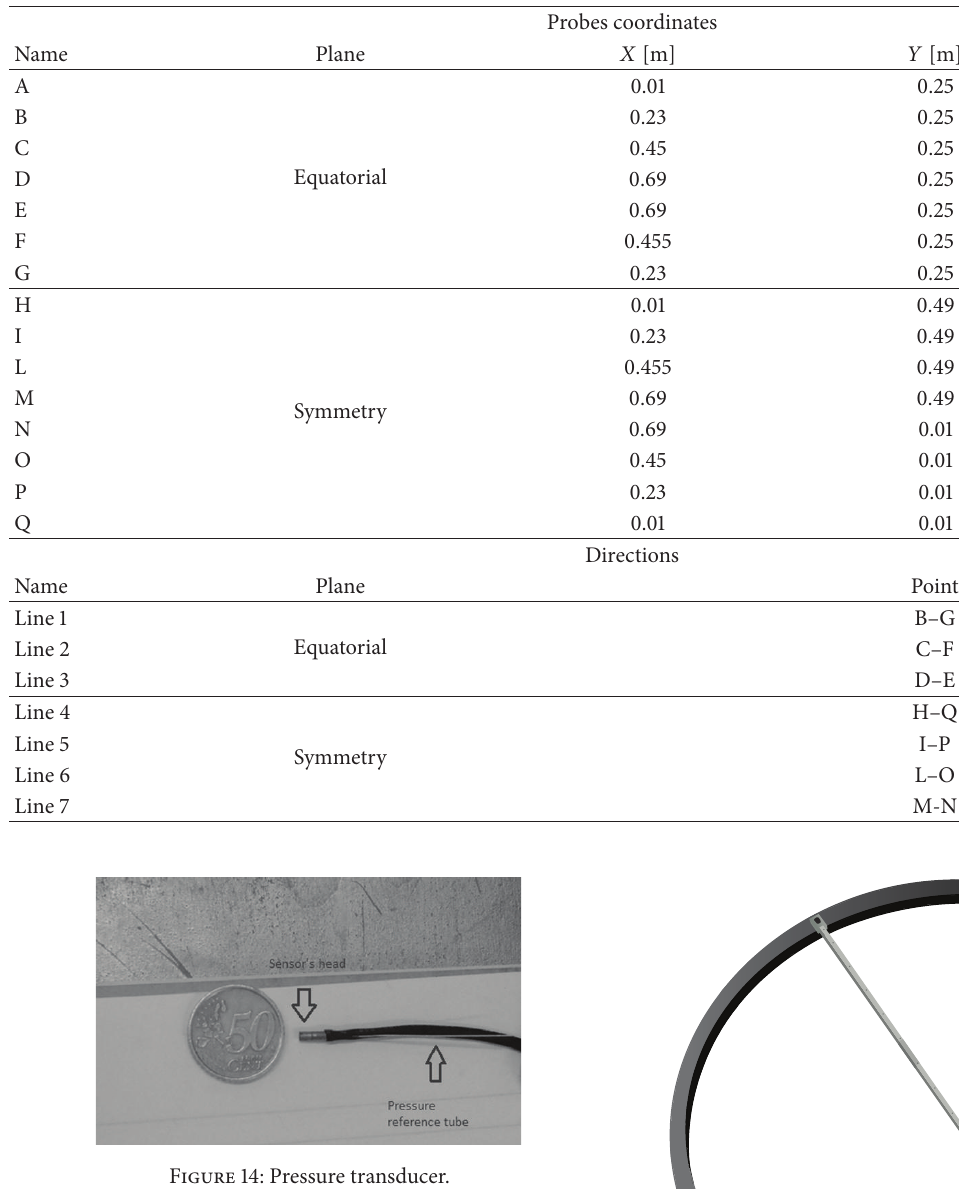
Table 2: Pressure transducers positions.